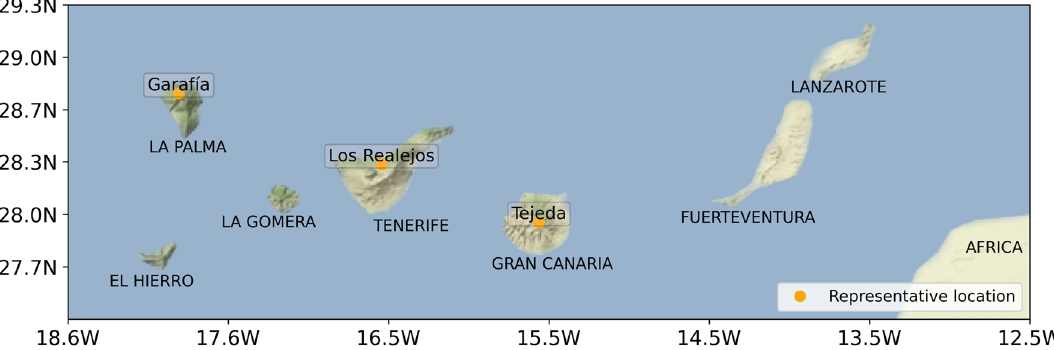
Figure 1. Location of Canary Islands and the three municipalities with the largest accumulated burnt areas during the study period. Map was created using the cartopy module version 0.18.0 (http:// scito ols. org. uk/ carto py/) for python 3.8.3 (http:// www. python. org/). The terrain image was downloaded on demand from the Stamen tile server (http:// stamen. com, under CC BY 3.0. Data by OpenS treet Map under